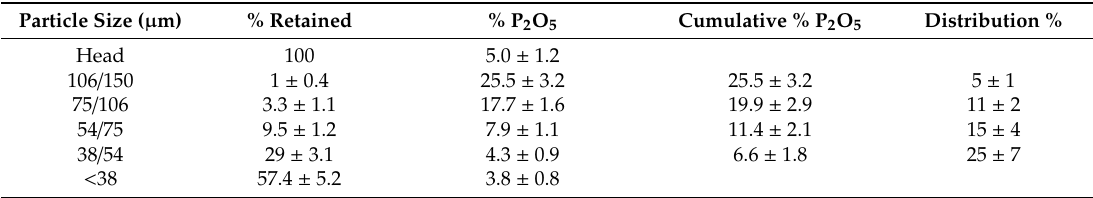
Table4. Phosphatecontentswithinthesizeintervalsoftheconcentrateofcarbonates(average ± standard deviation of 5 measurements from 5 random samples of the